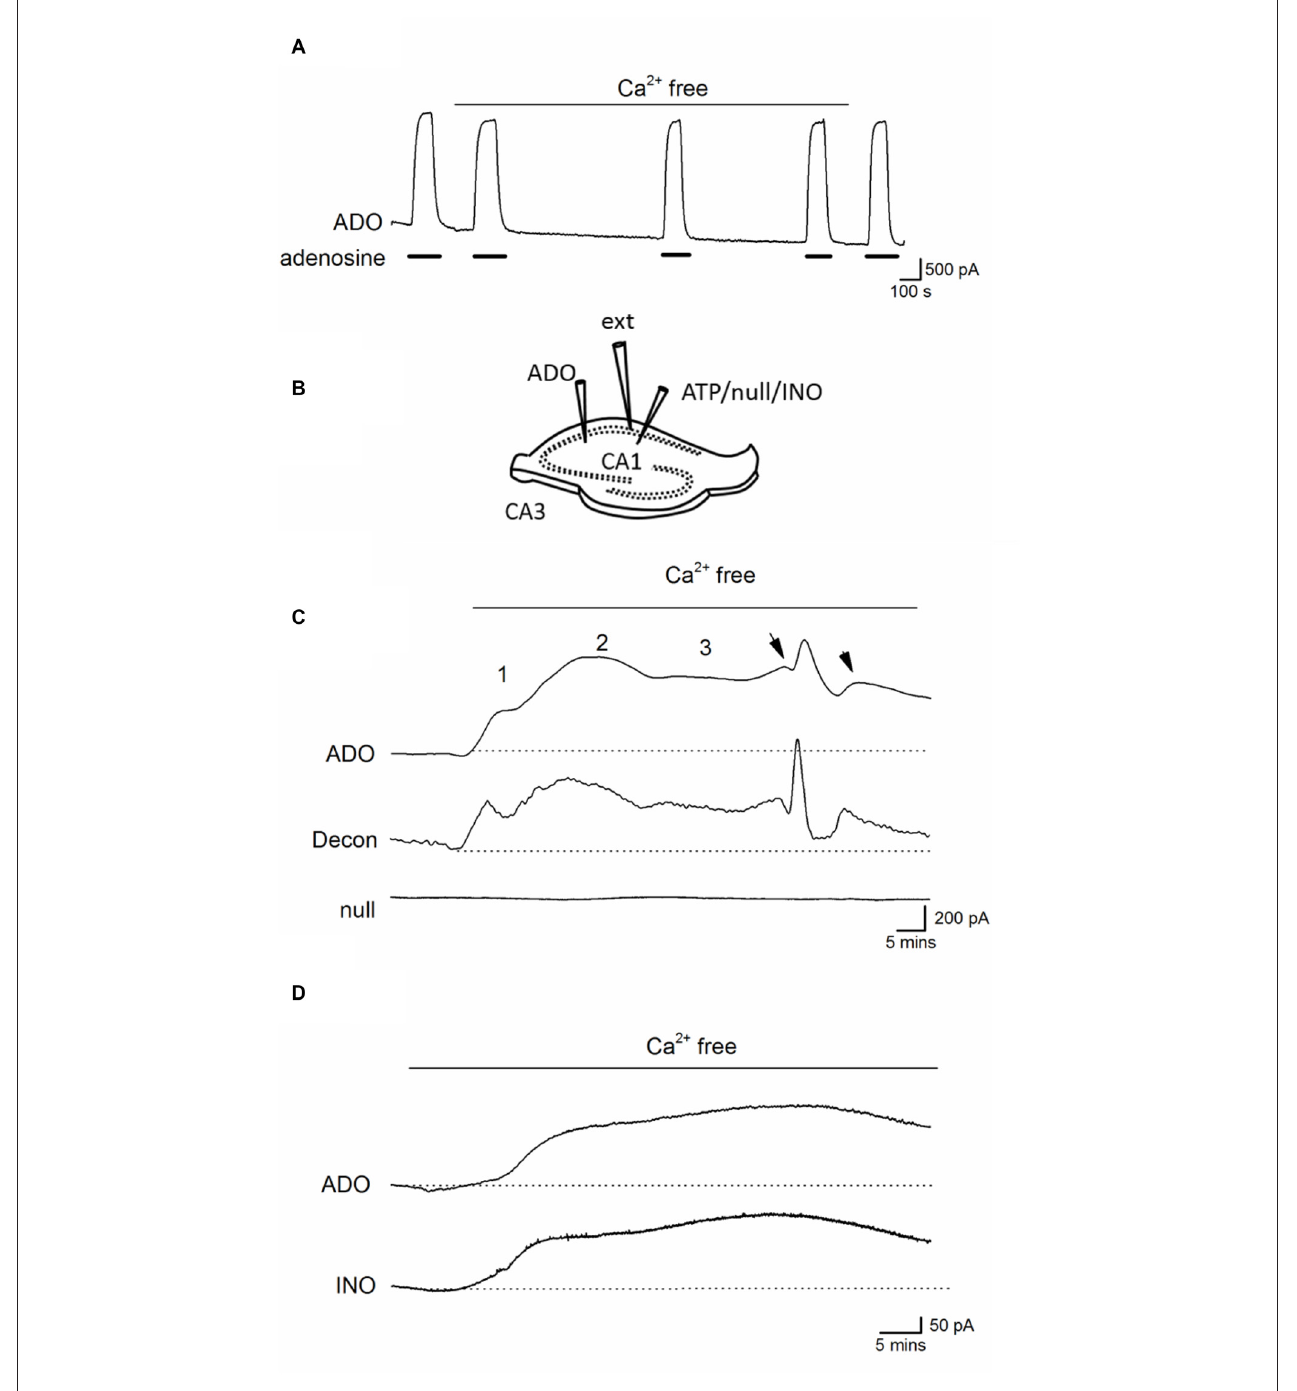
FIGURE 3 | Ca 2 + -free activity increases the concentration of extracellular adenosine. (A) Trace from an ADO biosensor illustrating that removal of extracellular Ca 2 + has no significant effect on the sensitivity to adenosine or baseline current (no slice was present). Adenosine (ADO) (10 µ M) was applied during the filled bars. (B) Diagram showing positioning of electrodes and biosensors in a hippocampal slice. (C) Traces from an adenosine (ADO) biosensor and null sensor both placed in CA1 approximately 0.5 − 1 mm apart. The ADO biosensor trace was deconvolved (Decon) with a time constant of 175 s to separate the release events. Application of Ca 2 + -free aCSF resulted in a large current on the ADO biosensor that was not observed on the null sensor. The current had three distinct phases with spontaneous events (arrows) superimposed on the sustained current in the latter phase. (D) Traces from ADO and INO biosensors during Ca 2 + free activity. The traces are very similar and, given that the ADO biosensor measures both adenosine and inosine, suggests there is little or no adenosine component, which is consistent with adenosine metabolism before detection.